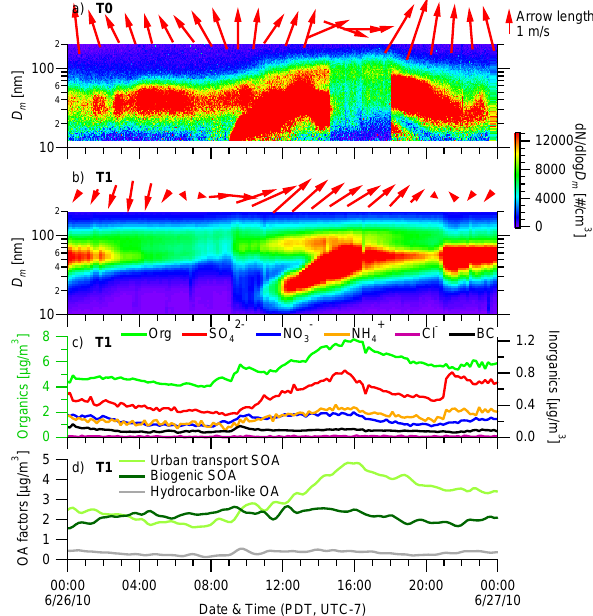
Figure 3. Comparison of the time evolution of the particle size dis- tributions at the (a) T0 and (b) T1 sites on 26 June, along with the hourly averaged wind direction (length of the arrows is proportional to the wind speed) for each site. Time series of (c) NR-PM 1 species and BC, and (d) three different organic aerosol